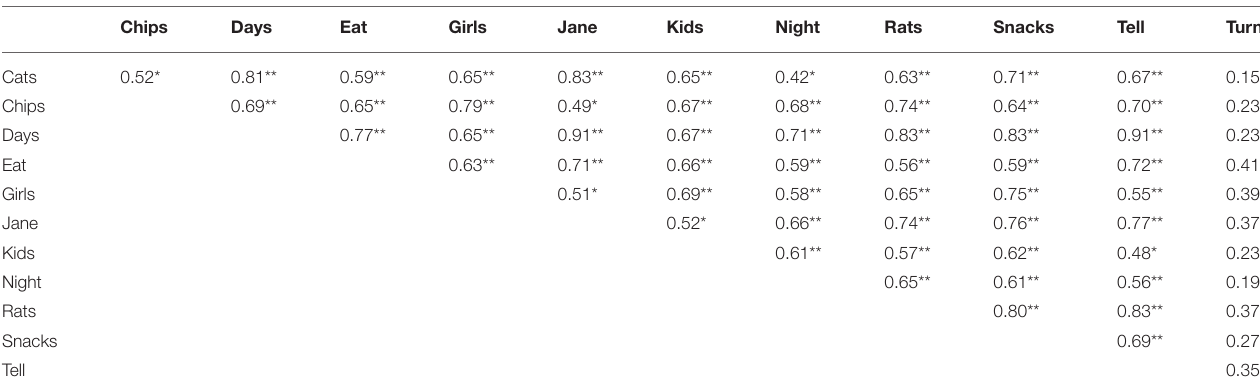
TABLE 1 | Correlations of Mean IOI between each pair of sentences in Experiment